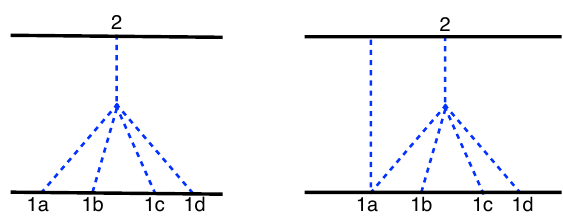
Figure 1 . A 3-loop non-factorizable diagram (left) and a 4-loop factorizable one (right) which can be computed as the product of the former with the Newtonian